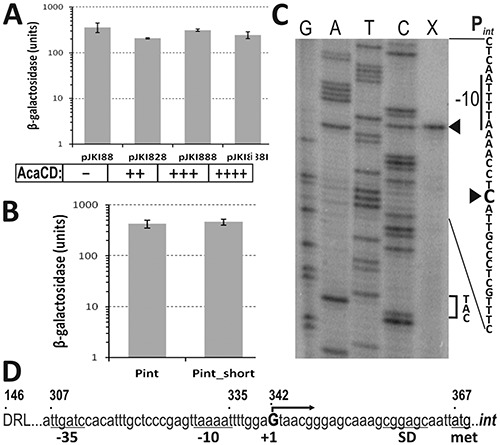
Analysis of promoter region Pint. (A) The effect of AcaCD on the expression from Pint region. The β-galactosidase assay was carried out with TG1 strain containing the tester plasmid pJKI995 (Pint) and AcaCD producer plasmids pJKI828 or pJKI888, respectively. Vector pJKI88 lacking acaCD genes was used as negative control. Producer plasmid containing Ptac (pJKI888) was measured under non-inducing and inducing (pJKI888i) conditions. The relative expression levels of acaCD are indicated. (B) β-Galactosidase assay of the full length (pJKI863, 146–366 bp) and truncated (pJKI870, 269–366 bp) Pint region. (C) Determination of int TSS. Primer extension reaction (lane X) was performed using total RNA purified from E. coli TG90 carrying pJKI995 and primer pUCfor21 annealing near to the start codon of lacZ gene. Lanes G, A, T, C: Sanger sequencing reactions obtained using pUCfor21 and pJKI995 template DNA. Arrowheads point to the C base on the non-transcribed strand corresponding to the G located 25 bp upstream from the ATG codon on the sense strand. The −10 box and the start codon are indicated. (D) Promoter region of int. Coordinates above the sequence refer to published SGI1 sequence (AF261825). The start codon, deduced Shine-Dalgarno, −10, −35 boxes and TSS of int are indicated.